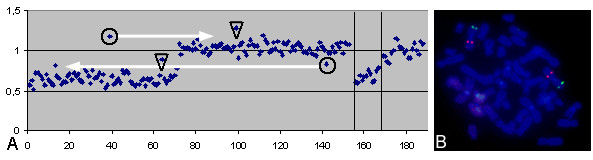
Mismapped clones. A. Array-CGH profile of UOK115 cell line. BAC/PACs covering chr3 are displayed in order on the X-axis from telomere of short arm (left), to telomere of long arm (right). Controls derived from chrX are plotted between the vertical lines right to chr3. Controls from autosomes are plotted to the right of the chrX controls. The Y-axis denotes the value of normalized fluorescence ratio (NFR) for each BAC/PAC clone (see Methods). The profile identifies 3p loss with ANILFR ± 1 sd; 0.7 ± 0.07. Two clones highlighted by circles, display outstanding fluorescence ratio than the neighbouring clones. On the plot arrows indicate real localizations revealed by FISH (RP11-129G16 locates at 3q12, clone RP11-732M7 at 3p24-25). Triangles indicate clones, which are part of segmental duplications identified by BLASTN. B. FISH image of normal metaphase with clones: RP11-994B16 (3q21.3), red, and the real localization of RP11-732M7, green, at 3q24-25.